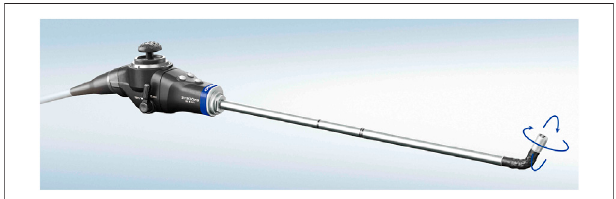
FIGURE 9 | ENDOEYE FLEX 3D © OLYMPUS CORPORATION (Tokyo, Japan).